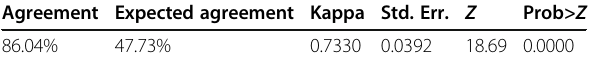
Table 1 Inter-rater calibration Agreement Expected agreement Kappa Std. Err.